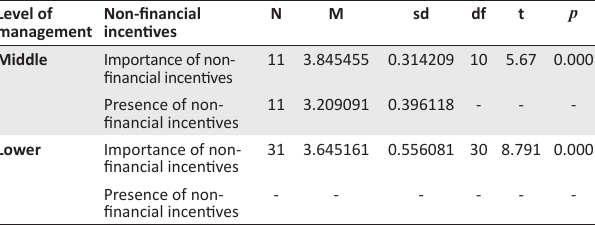
TABLE 3: Testing the difference between the level of presence and the importance of non-financial incentives.